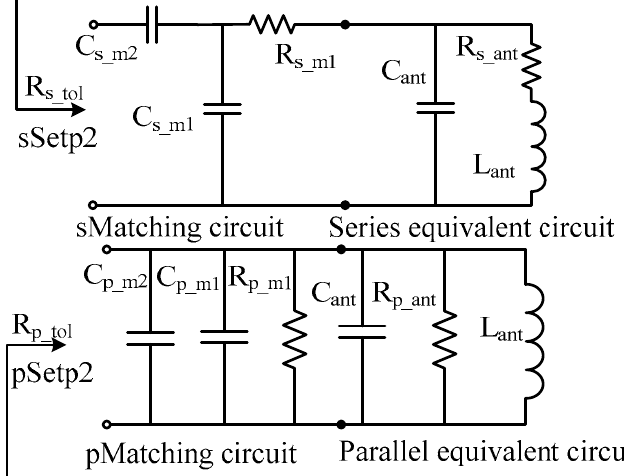
Figure 4. The interim circuit consisting of equivalent and matching circuits. However, according to existing literature, small antenna cannot obtain broad band- width unless some additional technologies are adopted. After integrating a matching circuit, an LC resonator must be introduced to the RF electronic system for a broader bandwidth as a third step. According to Equation (3), an LC resonator designed to exactly resonate at 13.56 MHz can efficiently widen the bandwidth according to RF electronic rules as seen in Figure 5. Moreover, small values of inductance and large values of capacitance have good performance in widening the impedance bandwidth at low frequency.